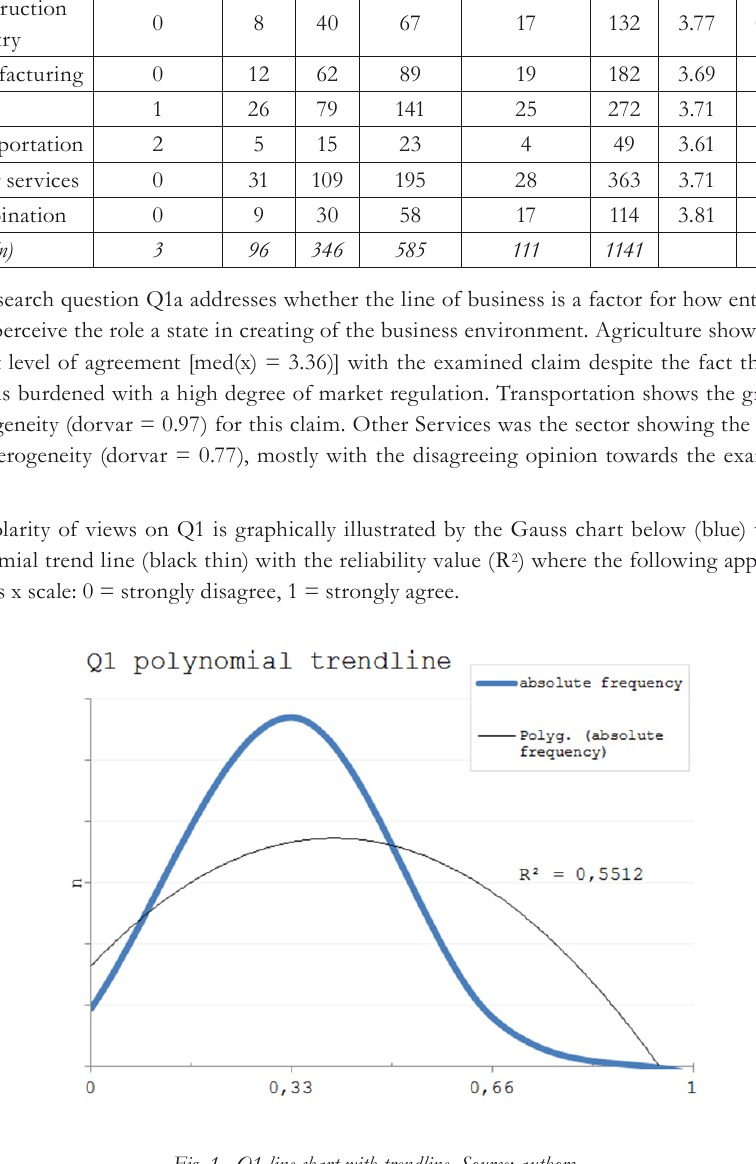
Fig. 1 - Q1 line chart with trendline. Source: